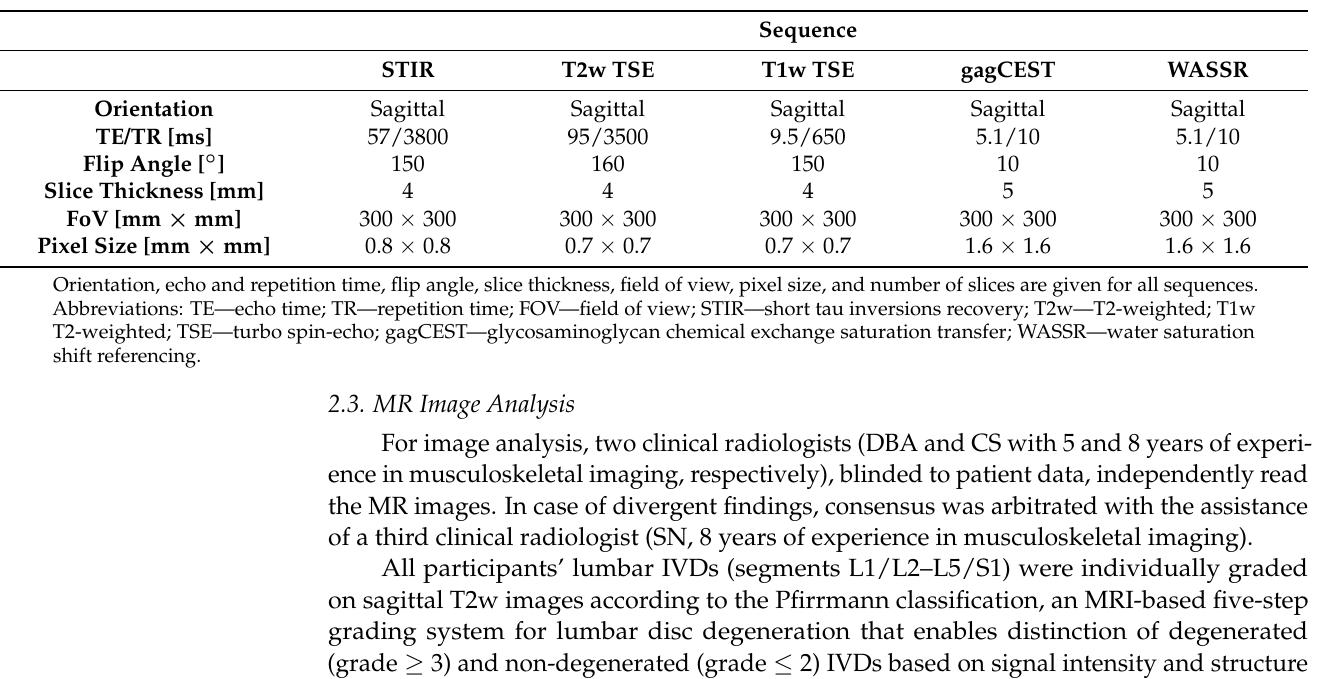
Table 2. Morphological and compositional magnetic resonance imaging (MRI) sequence